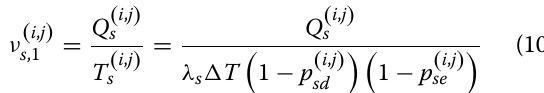
paper, the discharge voltage is a predefined parameter and the total power used for data transmission at each transmit UE can be calculated according to the remaining battery capacity. α is constant to indicate the non-linear effect, and its value is around